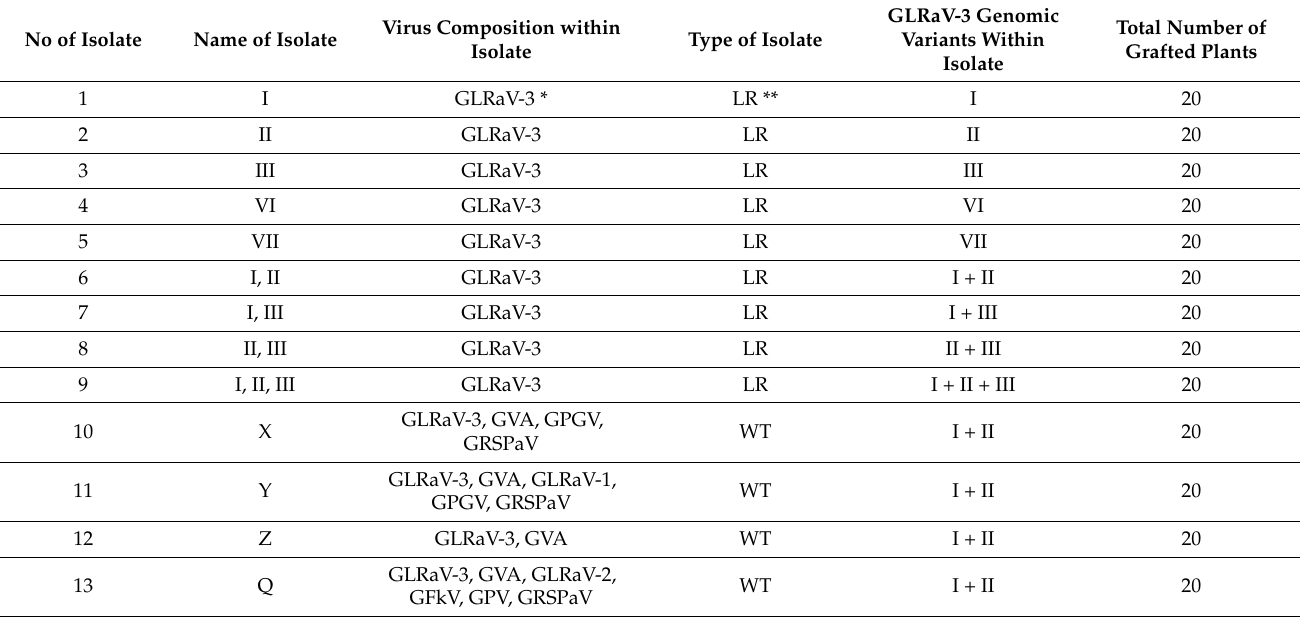
Table 1. Viral isolates composition and the total number of grafted grapevine plants per isolate